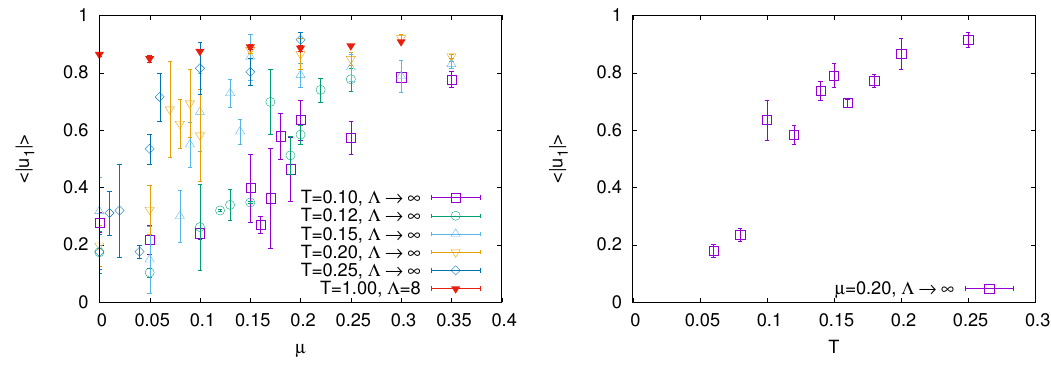
Figure 8 . The V.E.V. hj u 1 ji for D = 3 ; N = 16. For the high temperature T = 1 : 00, we put the result of (cid:3) = 8 without large-(cid:3) extrapolation.